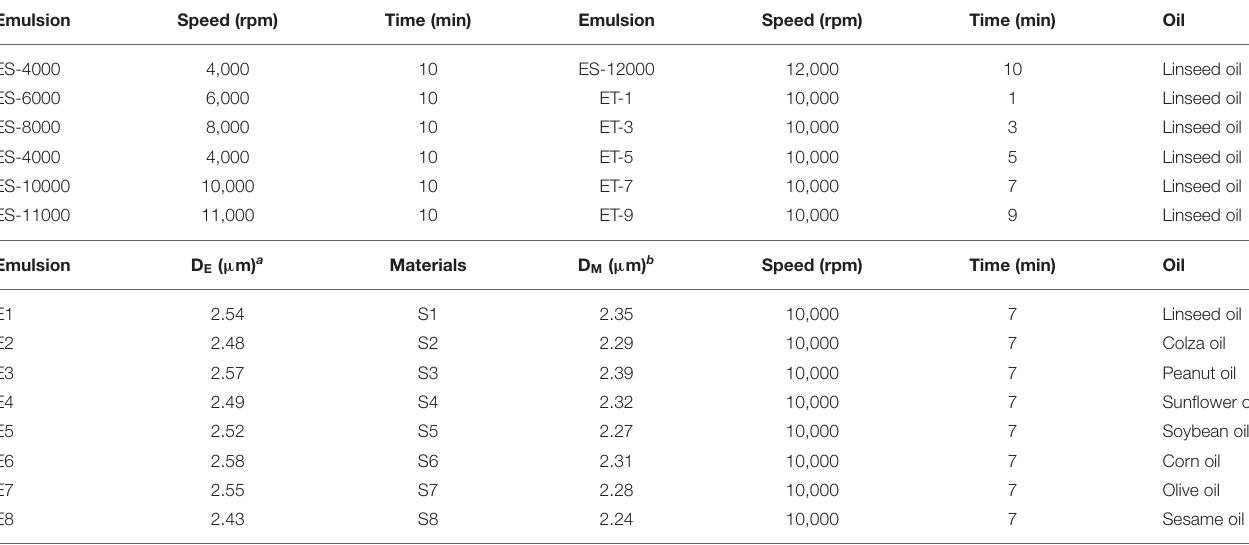
TABLE 1 | Feed composition of Pickering MIPE formulations and porous CMC- g -PAM/ATP monoliths and their corresponding average droplet and pore sizes.